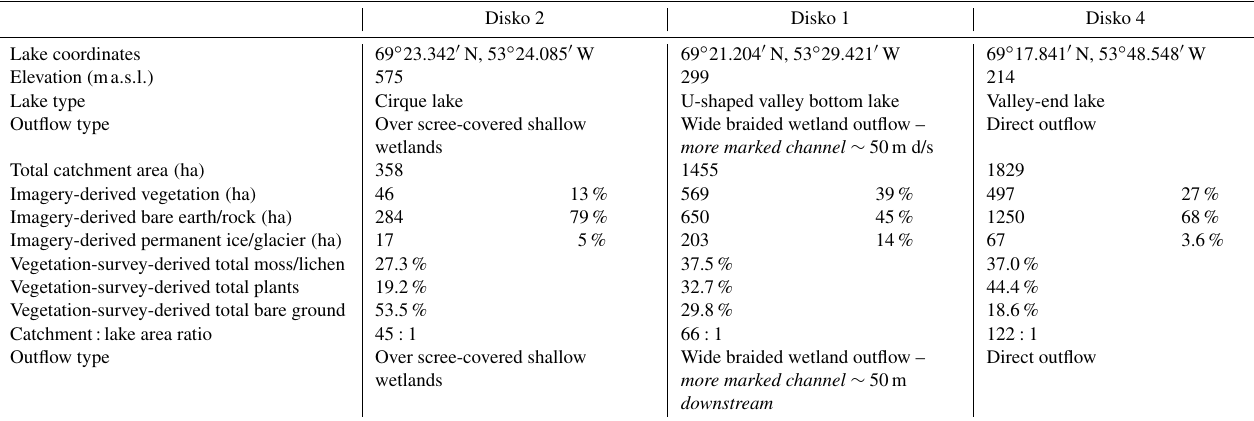
Table 1. Key lake characteristics. Presented in descending elevation order.